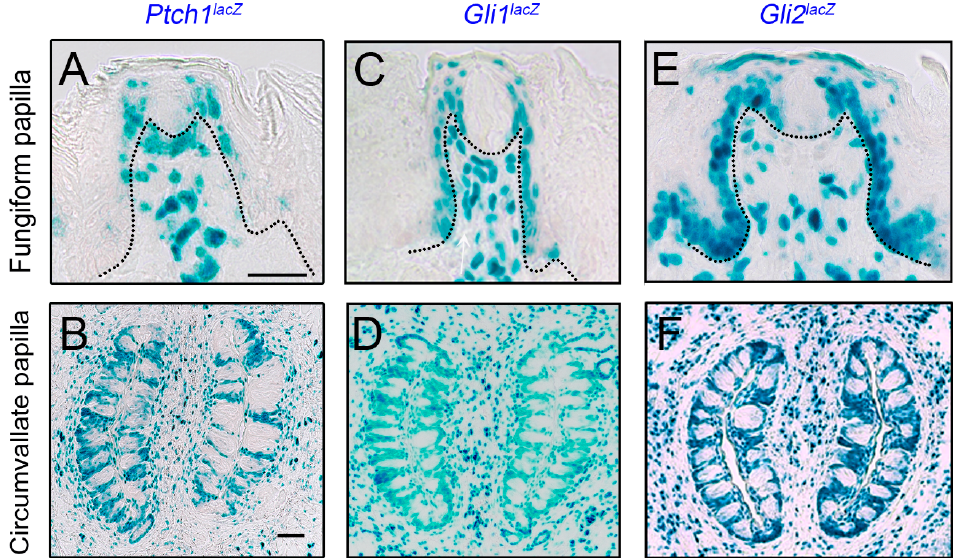
Figure 4. Hedgehog signaling components in anterior and posterior tongue papillae. ( A – F ). X-Gal staining (blue) for Ptch1 lacZ ( A , B ), Gli1 lacZ ( C , D ), and Gli2 lacZ ( E , F ) mice in taste fungiform ( A , C , E ) and circumvallate ( B , D , F ) papillae. Ptch1 and Gli1 are expressed in papilla basal epithelial, perigemmal, and stromal cells, while Gli2 is additionally present in anterior tongue non-taste, filiform basal epithelial and stromal cells. Black dotted lines in ( A , C , E ) demarcate the basal lamina. Scale bar (50 μ m) in ( A ) applies to ( A , C , E ) and in ( B ) applies to ( B , D , F ).